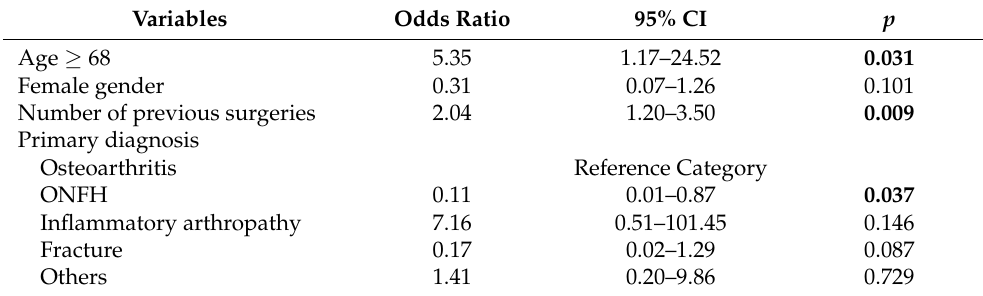
Table 5. Predictors of moderate to severe malnutrition identified by CONUT at the 1st stage